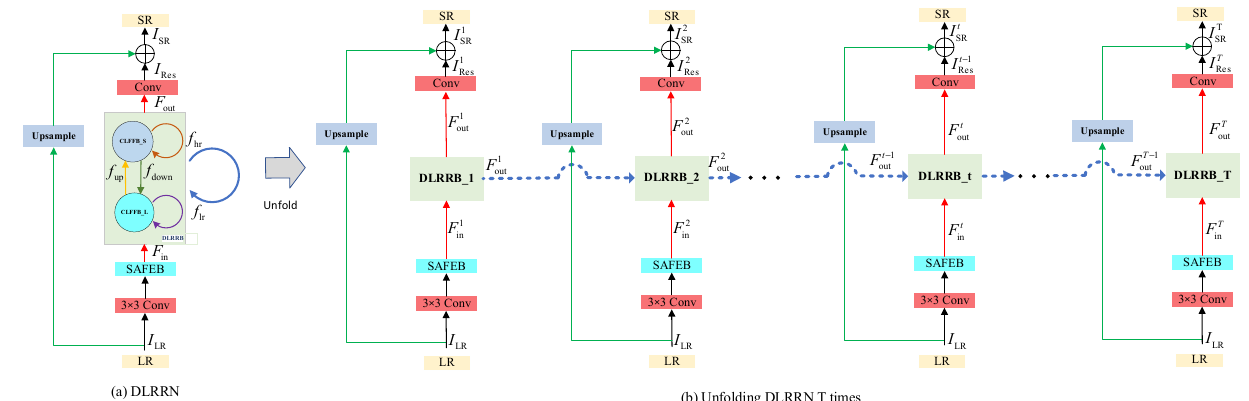
Figure 2. The recurrent structure of the DLRRN is defined as shown in ( a ), and ( b ) is the unfolded DLRRN. Blue arrows represent feedback information flow and green arrows represent global residual skip connections.